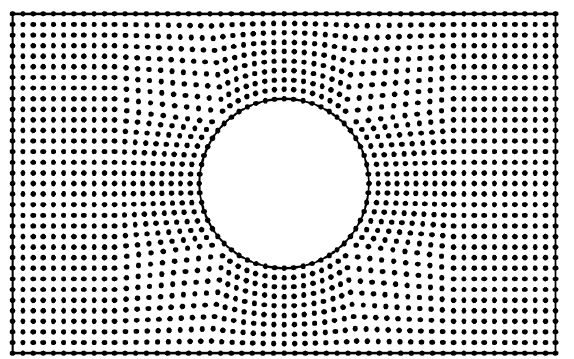
Figure 30. Nodal configurations for a perforated tension strip.